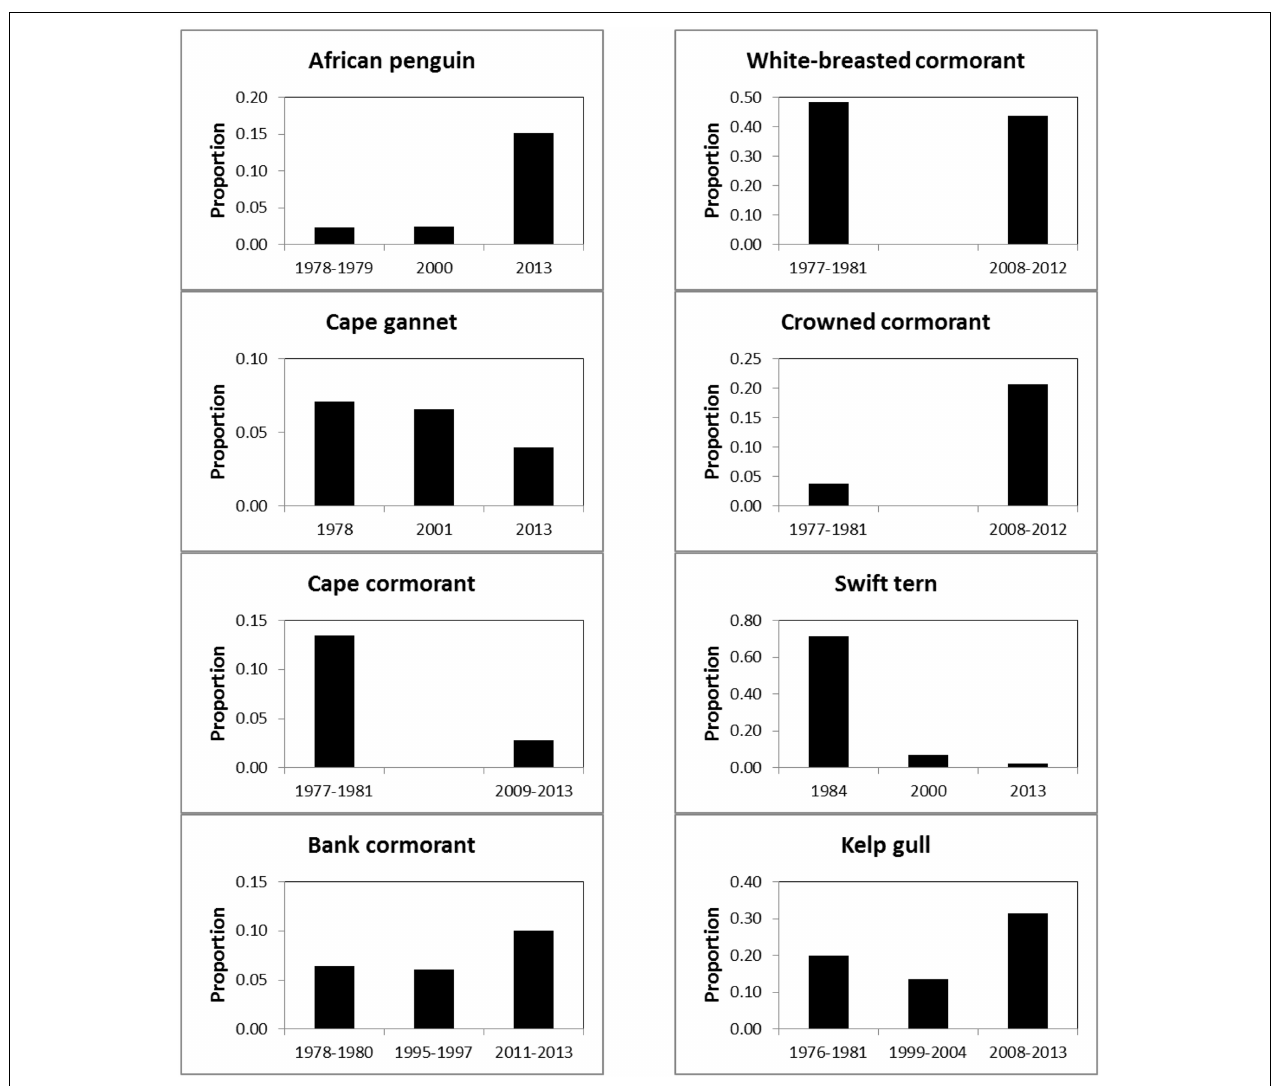
FIGURE 3 | Proportions of eight seabirds breeding on South Africa’s mainland, as opposed to its maritime islands, during 1977–1984, 1995–2004, and